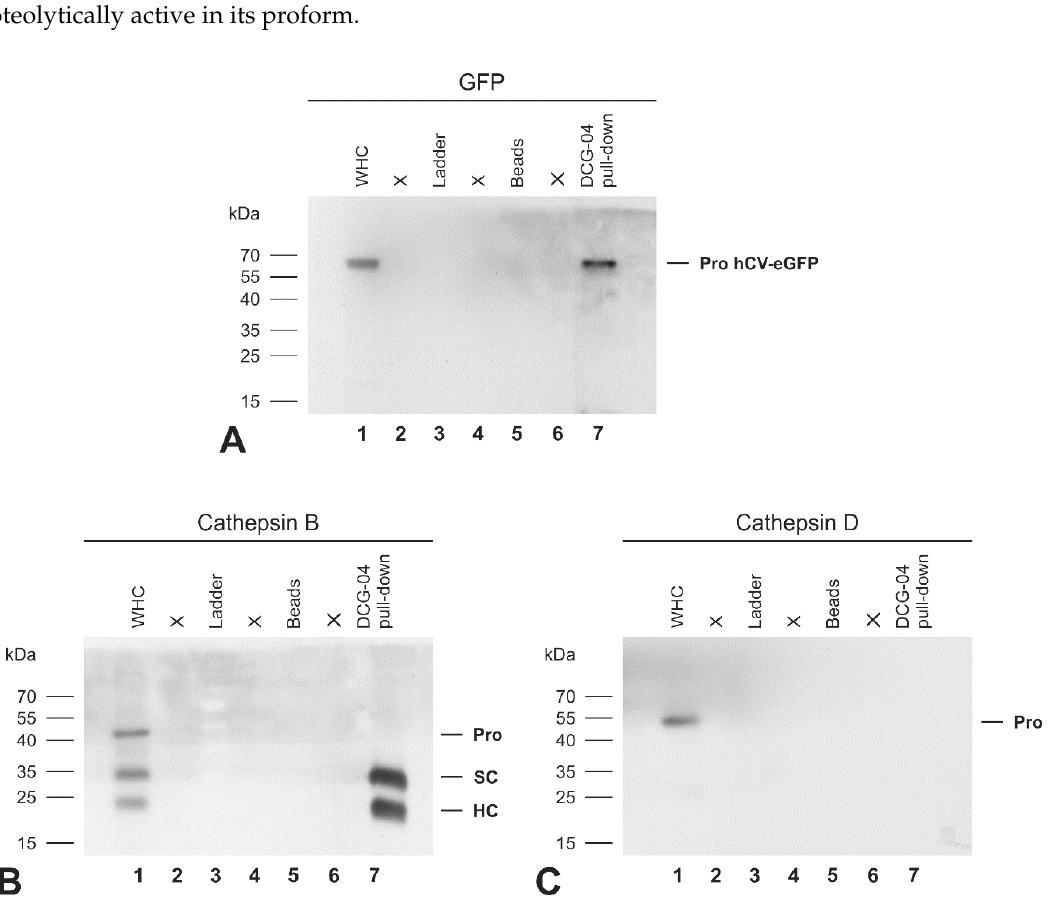
Figure 8. Detecting the proform of hCV-eGFP chimeric protein with the activity-based probe DCG-04. Lysates (WHC, lanes 1, respectively) were prepared from Nthyori-CV cells in the presence of biotinylated DCG-04, which requires an accessible active site in order to bind covalently to proteolytically active cysteine peptidase forms in a 1:1 ratio. The whole cell lysate was then incubated with streptavidin beads to pull down DCG-04-labeled proteins (DCG-04 pull down, lanes 7, respectively), representing active cysteine peptidase forms. Immunoblots were probed with anti-GFP ( A ), anti-cathepsin B ( B ), and anti-cathepsin D ( C ) antibodies. Molecular mass markers are indicated in the left margins. It was found that the active site of the proform of the hCV-eGFP chimeric protein was fully accessible for binding to DCG-04, indicating its proteolytic activity ( A , lane 7). The whole cell lysate contained the expected molecular forms of cathepsin B, i.e., proform (pro), single chain (SC), and the heavy chain (HC) of the two-chain form ( B , lane 1), while only the mature forms of